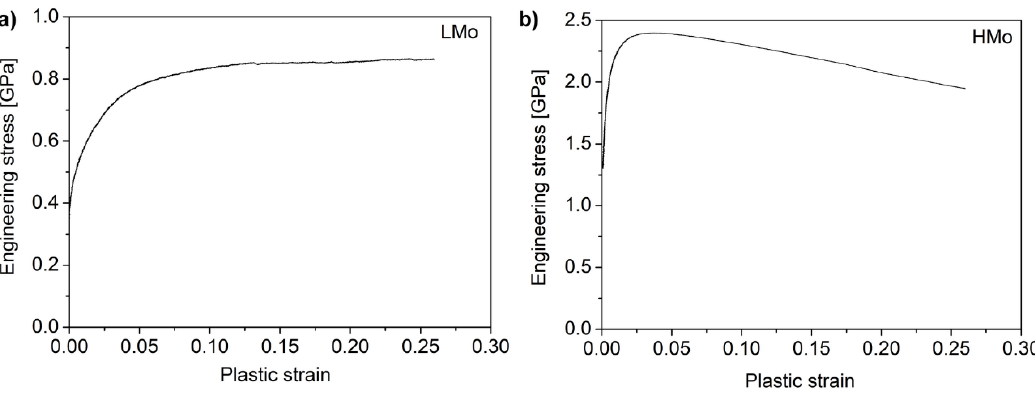
Figure 5. Engineering stress versus plastic strain obtained by micropillar compression for the films LMo ( a ) and HMo ( b ).